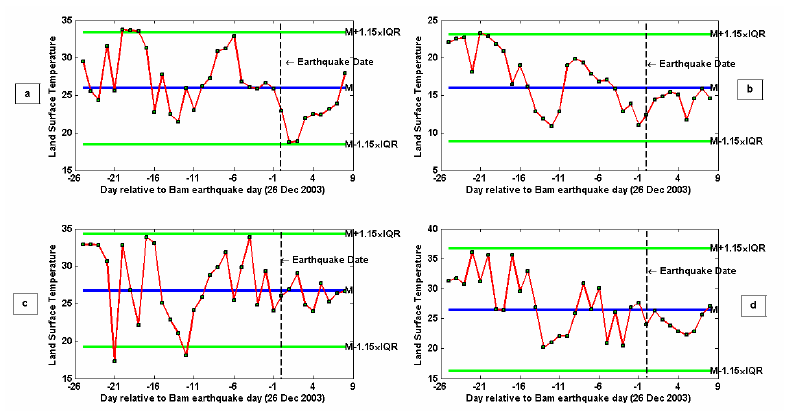
Fig. 10. Results of LST data analysis for the Bam earthquake (26 December 2003) epicenter and other regions which have been shown in Fig. 7, from 1 December 2003 to 3 January 2004. The panels represent LST variations and detected anomalies using interquartile methods in region (a) on earthquake epicenter, (b) 1, (c) 2 and (d) 3.